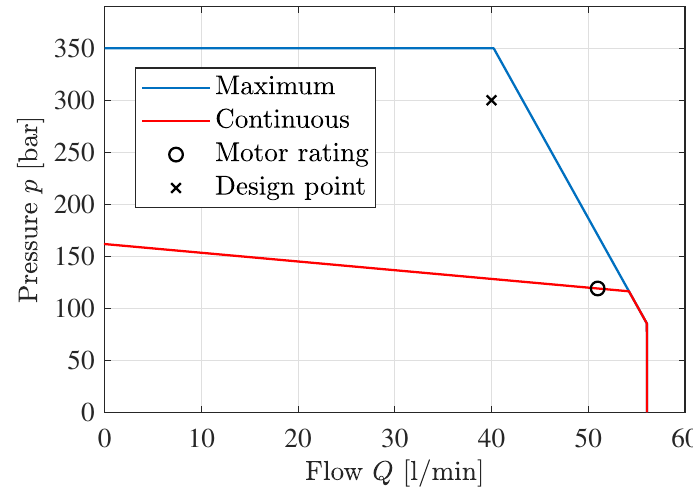
Figure 9. Flow-pressure curve with selected motor and